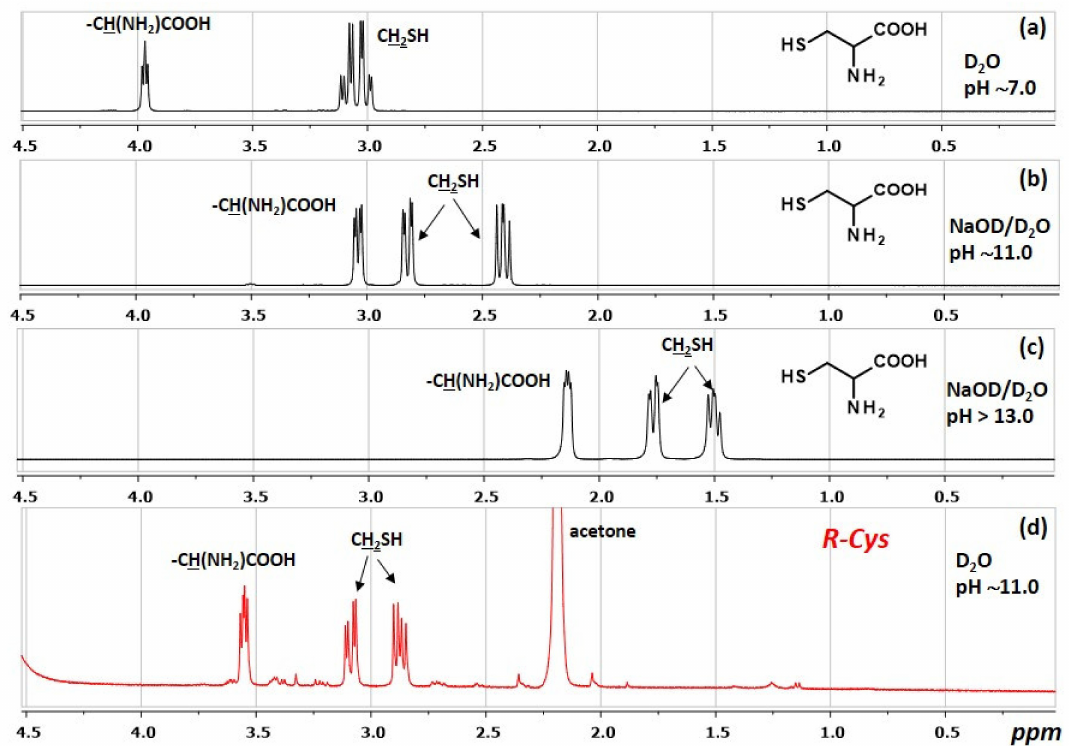
Figure 5. 1 H NMR spectra of L-cysteine ( Cys ) in D 2 O, in pH ~7.0 ( a ), in NaOD/D 2 O, in pH ~11.0 ( b ), >13.0 ( c ) and D 2 O dispersion of AgInS 2 -ZnS nanocrystals capped with L-cysteine: R-Cys in pH ~11.0 ( d